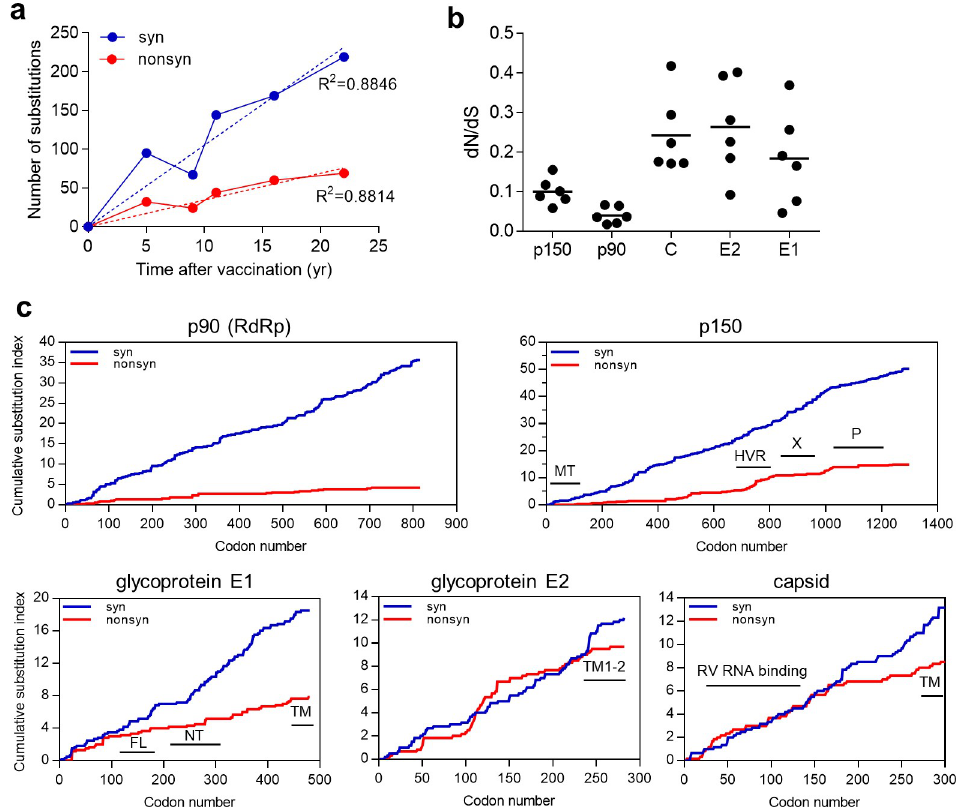
Fig 4. Analysis of iVDRV evolution patterns. a. Relationship between the number of synonymous and nonsynonymous substitutions in the consensus genomic sequences directly from the specimens (RVs) and time elapsed after vaccination. b. Sequence divergence of the individual genes by a patient. dN/dS ratios were calculated with the SNAP tool. c. Plots of cumulative behavior of the average number of synonymous and nonsynonymous substitutions per a codon (cumulative substitution index) across each gene were calculated with the SNAP tool. Underlying data for Fig 4C can be found in the S5 Data file. The following domains are indicated: MT—methyltransferase, HVR -hypervariable region, X—ADP-ribose binding, P—protease, FL—fusion loops I and II, NT—neutralizing epitopes, TM —transmembrane domains. Note the NT domain is actually composed of four separate epitopes.